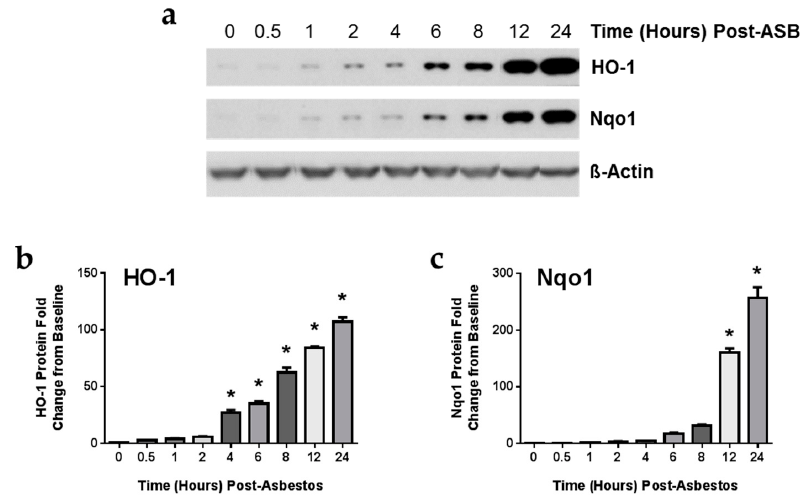
Figure 5. Asbestos Exposure Induces the Expression of Phase II Antioxidant Enzymes. Elicited murine peritoneal macrophages were harvested after 0, 0.5, 1, 2, 4, 5, 8, 12, and 24-h of asbestos exposure and evaluated by ( a ) Western blotting for HO-1 and Nqo1. Densitometric analysis of band intensity for ( b ) HO-1 and ( c ) Nqo1 was normalized to β -actin and values are expressed as fold change from CTL at time 0. Data are presented as mean ± SEM. * indicates a statistically significant ( p < 0.05) increase in HO-1 and Nqo1 protein levels above baseline values at time 0.